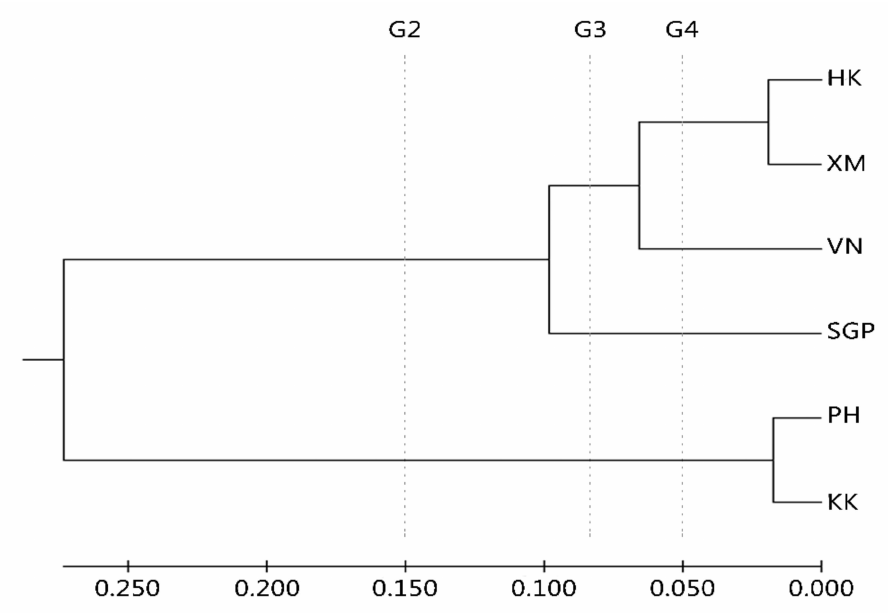
Figure 4. UPGMA tree showing relationships between the 6 sampling sites.